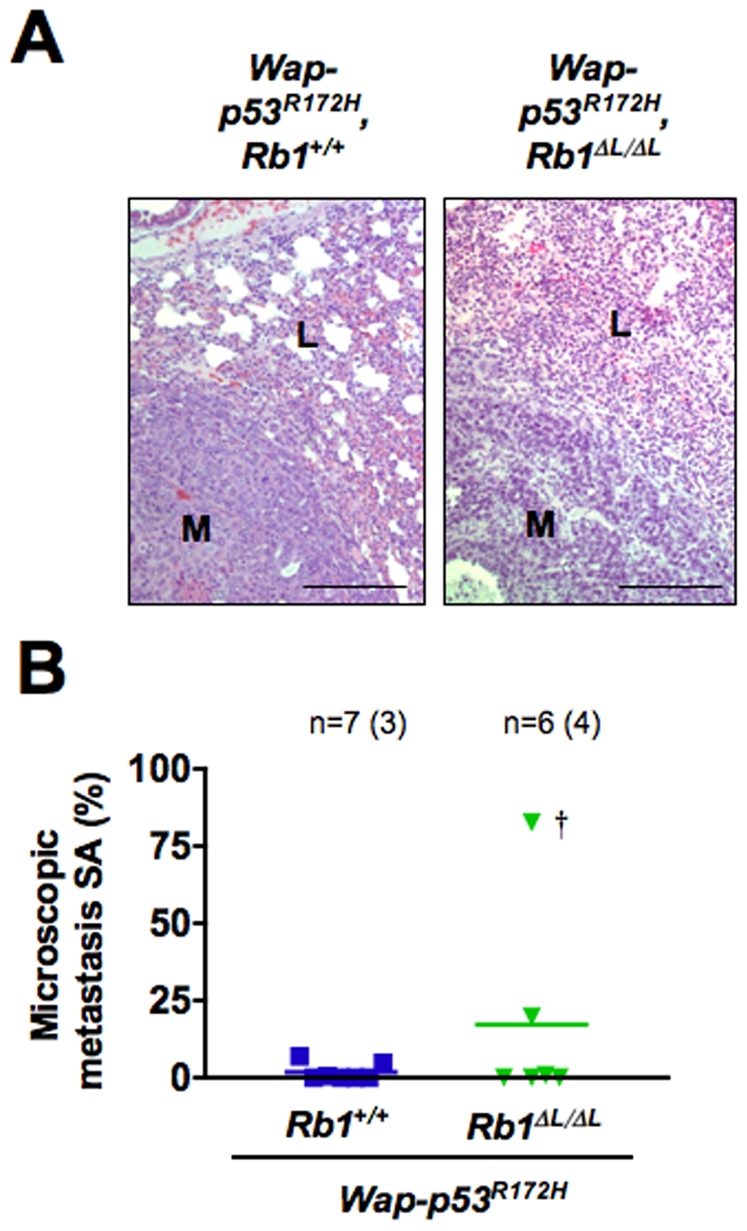
Metastases form in the Wap-p53R172H; Rb1
+/+ and Wap-p53R172H; Rb1ΔL/ΔL mice.A) Representative H&E stained paraffin sections of lungs harvested from tumor-burdened mice of each genotype. M denotes metastasis, and L denotes neighboring lung tissue. Scale: 100 µm. B) The surface area (SA) occupied by lung metastases relative to the total lung area in tissue sections was quantified for mice from each genotype along with the average SA. Values in brackets indicate the number of mice that developed metastases and † indicates a female that developed metastases to both the lung and spleen.